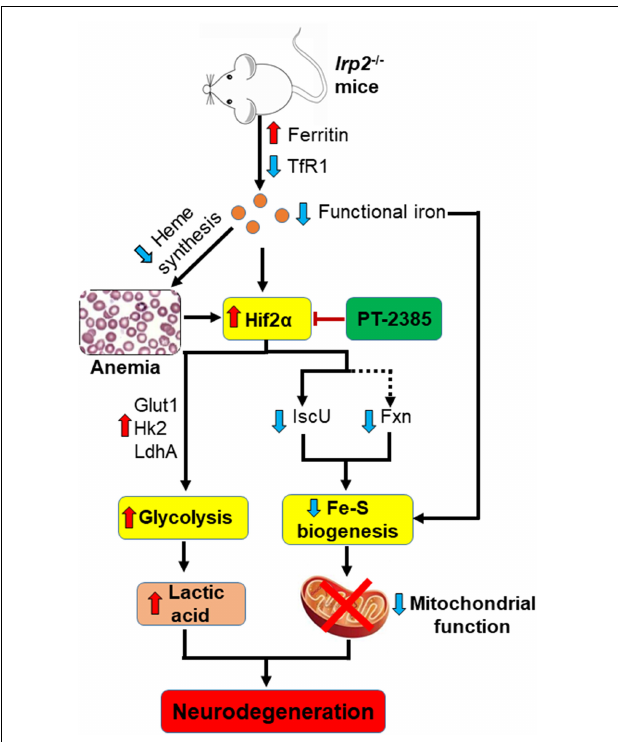
FIGURE 6 | A working model to illustrate the potential target, Hif2 α , in the therapeutic application of Irp2 loss-triggered neurodegenerative syndrome. Irp2 depletion causes the deficiency of cellular functional iron by decreased transferrin receptor and increased ferritin, which compromise the heme biosynthesis and finally trigger microcytic anemia in mice. Both the iron deficiency and anemia/hypoxia upregulate Hif2 α expression in vivo . The elevated Hif2 α upregulates glycolytic pathway-related genes to enhance glycolysis, while downregulates iron–sulfur cluster biogenesis-related genes, Fxn and IscU, to weaken mitochondrial function. After the inhibition of Hif2 α by PT-2385, the energy metabolism is shifted from glycolysis to oxidative phosphorylation in Irp2 − / − mice and neurodegenerative symptoms are